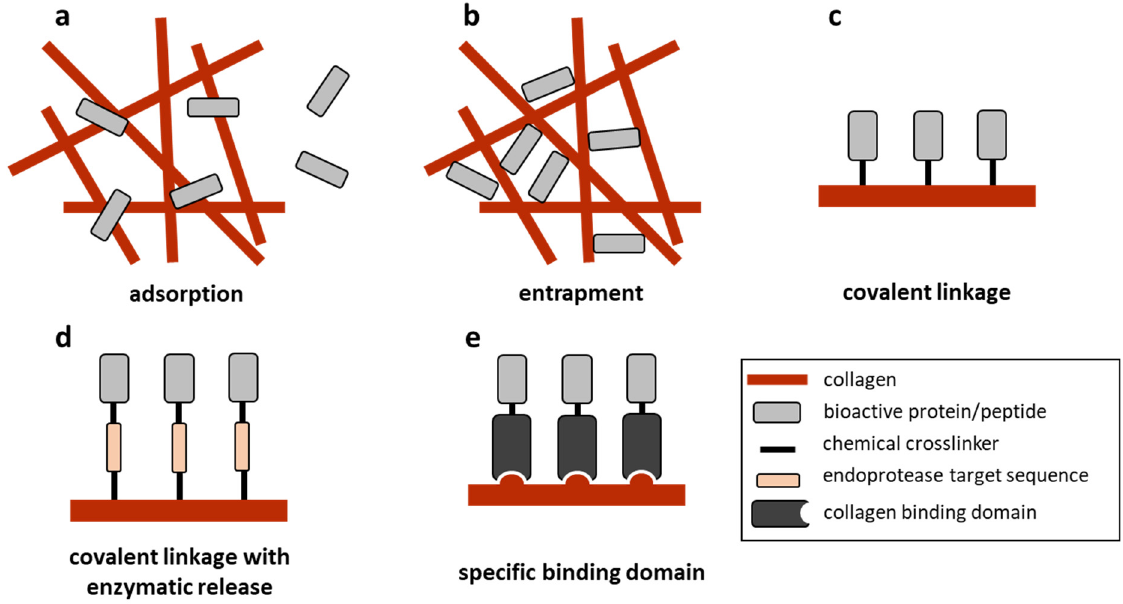
Figure 4. Schematic representation of different approaches for administering bioactive molecules in/on a collagen-based biomaterial for tissue engineering purposes: adsorption ( a ), entrapment ( b ), covalent linkage (with or without controlled release, ( c , d ) or specific binding through collagen binding domains ( e